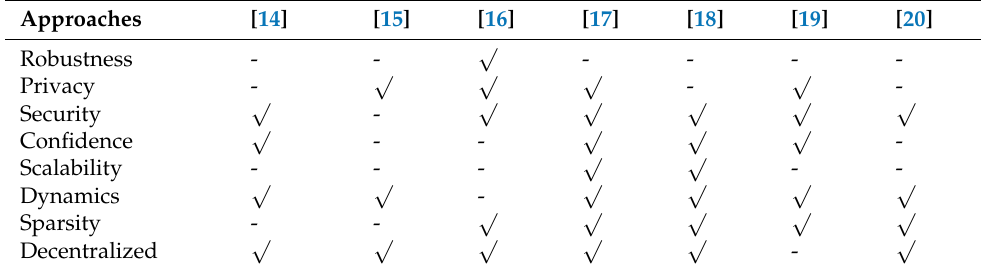
Table 1. Trust models and their